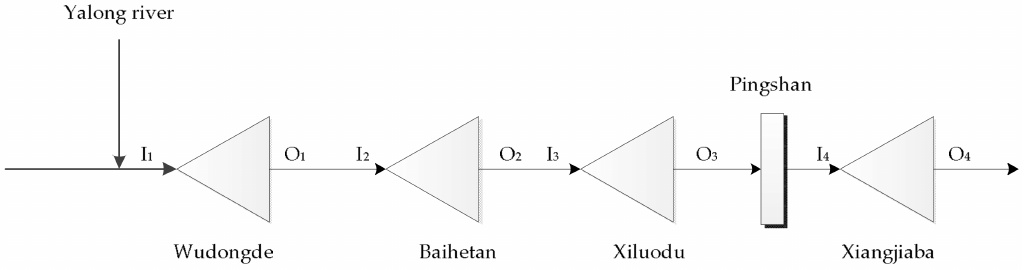
Figure 5. Topology of reservoirs in the Jinsha